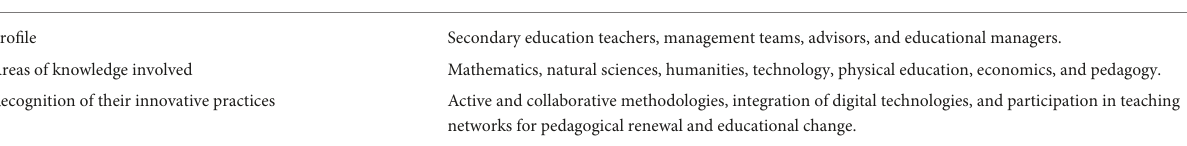
TABLE 1 Profile of the participating experts.